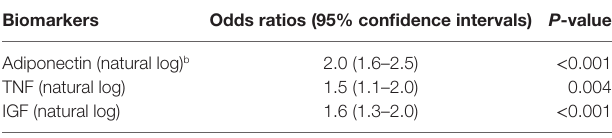
TaBle 4 | Multivariate analysis of serum biomarkers in cases and controls. a Biomarkers